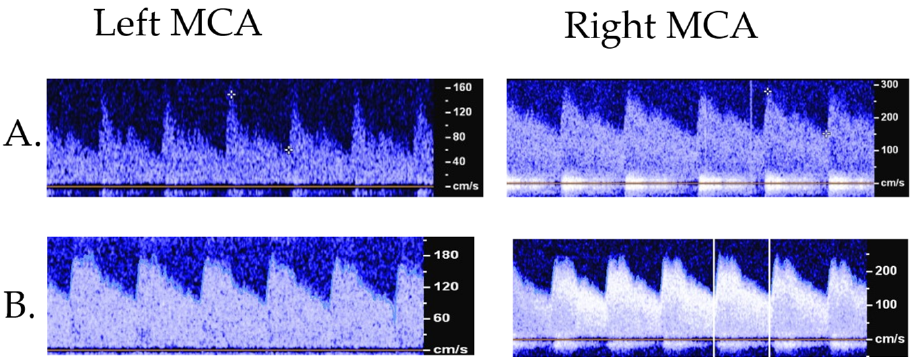
Figure 4. Example of TCD with concern for vasospasm ( A ) versus hyperemia ( B ). A: 11-year-old male with an arteriovenous malformation that developed concern for vasospasm on TCD which was con- firmed on additional imaging. Flow velocities (cm/s): right MCA—Vs 280, Vm 195 (+9.7 SD from normative), Vd 152, LR: 3.7; left MCA—Vs 150, Vm 90 (+0.92 SD), Vd 59.7, LR: 1.6. B: 11 yo female